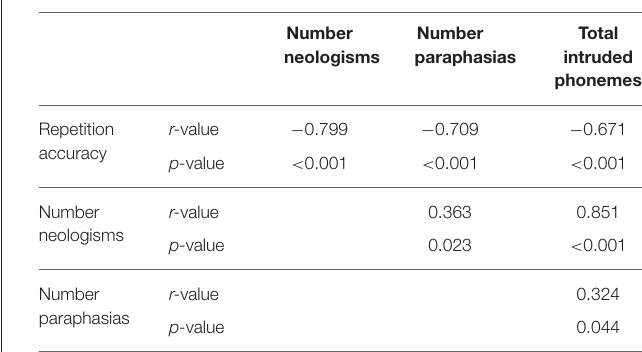
TABLE 5 | Correlations coefficients displaying medium-strong relationships between jargon score components.